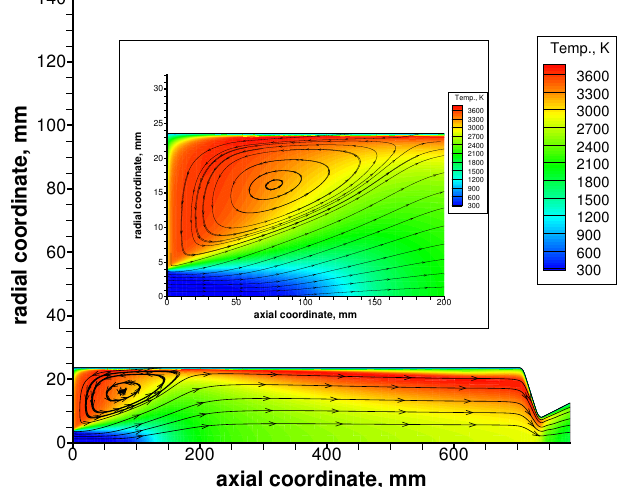
Figure 3. Temperature field and detail of the recirculation zone for Firing Test #19 (not to